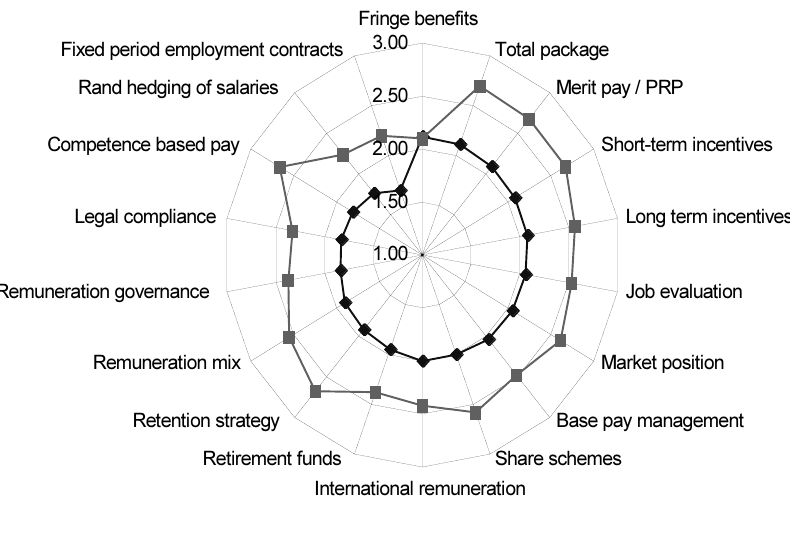
Figure 2: Gap analysis of extent of change of remuneration policy and impact of change on the organisation – private sector